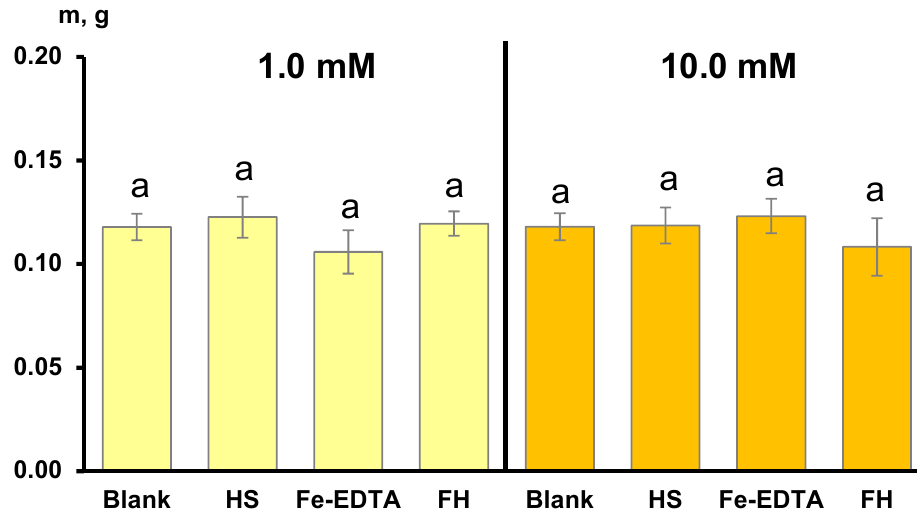
Figure 4. Dry biomass of the wheat shoots after foliar application of the iron-sources: ferrihydrite (FH) and Fe-EDTA, and control solutions: triple-distilled water (blank) and potassium humate (HS). The iron concentration in the fertilizer sprays was 1.0 mM (highlighted in yellow) and 10.0 mM (highlighted in orange). The bars represent the standard deviation ( n = 5). The columns marked with di ff erent letters are significantly di ff erent at p < 0.05 according to LSD test.